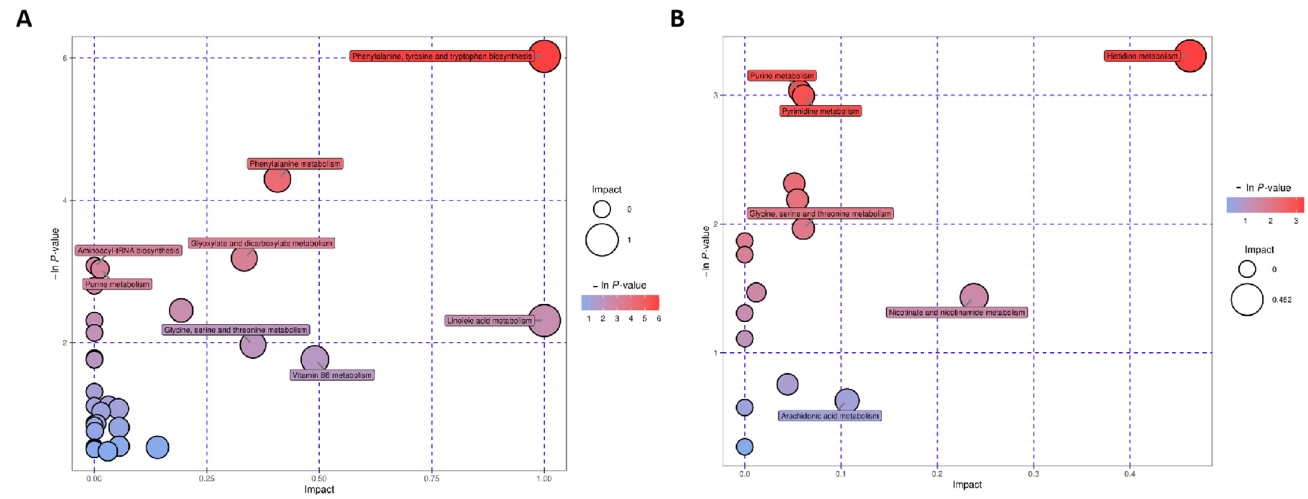
Figure 5. KEGG pathway indicating the top 20 involved pathways of significantly changed metabolites under the positive model ( A ) and the negative model ( B ). The spot size stands for the compound number of metabolites, and the color stands for the p value.